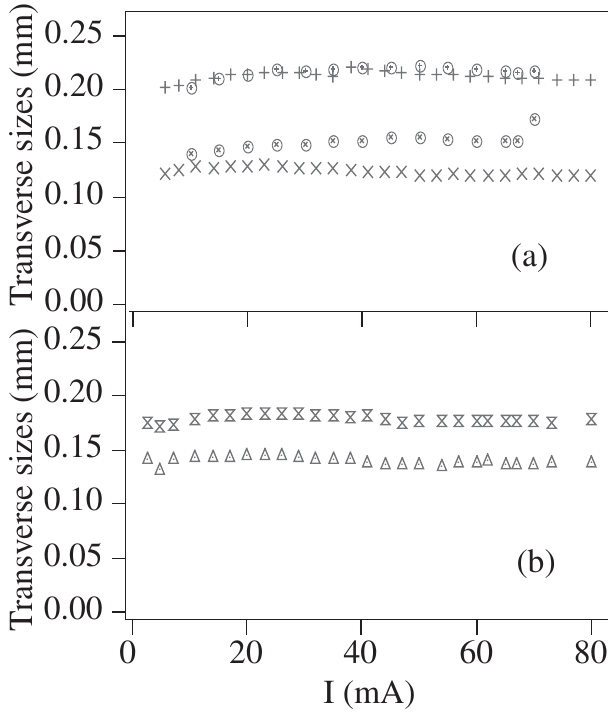
FIG. 2. Transverse size measurements performed at BL3: (a) achromatic optics (two series of measurements): (+) and ( (cid:10) ) for (cid:2) , ( (cid:2) ) and ( (cid:11) ) for (cid:2) , (b) chromatic optics: (cid:2) x z ( 4 ). Data have been treated taking into account the linearity of the employed CCD camera (Vixen C004-3M). Measurement accuracy: